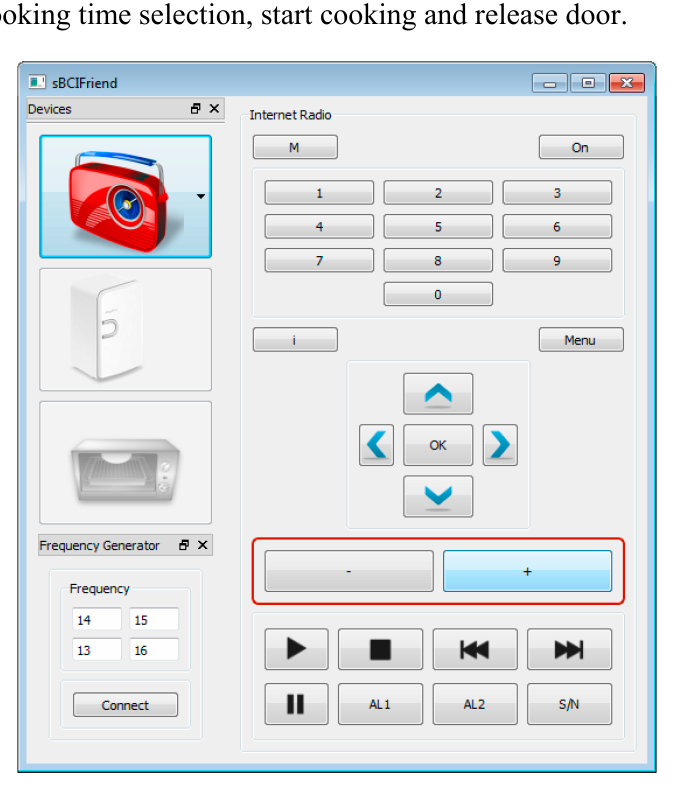
Figure 7. GUI for the internet